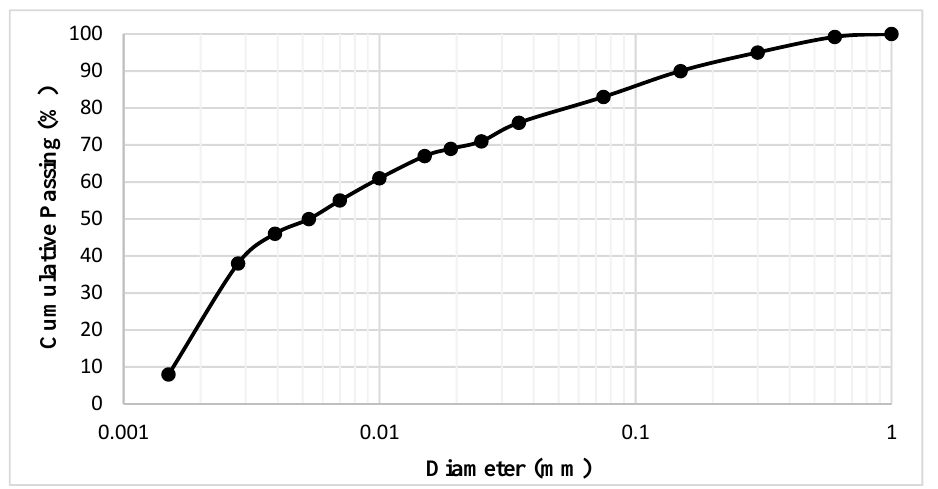
Figure 1. Grain size distribution of the natural soil.